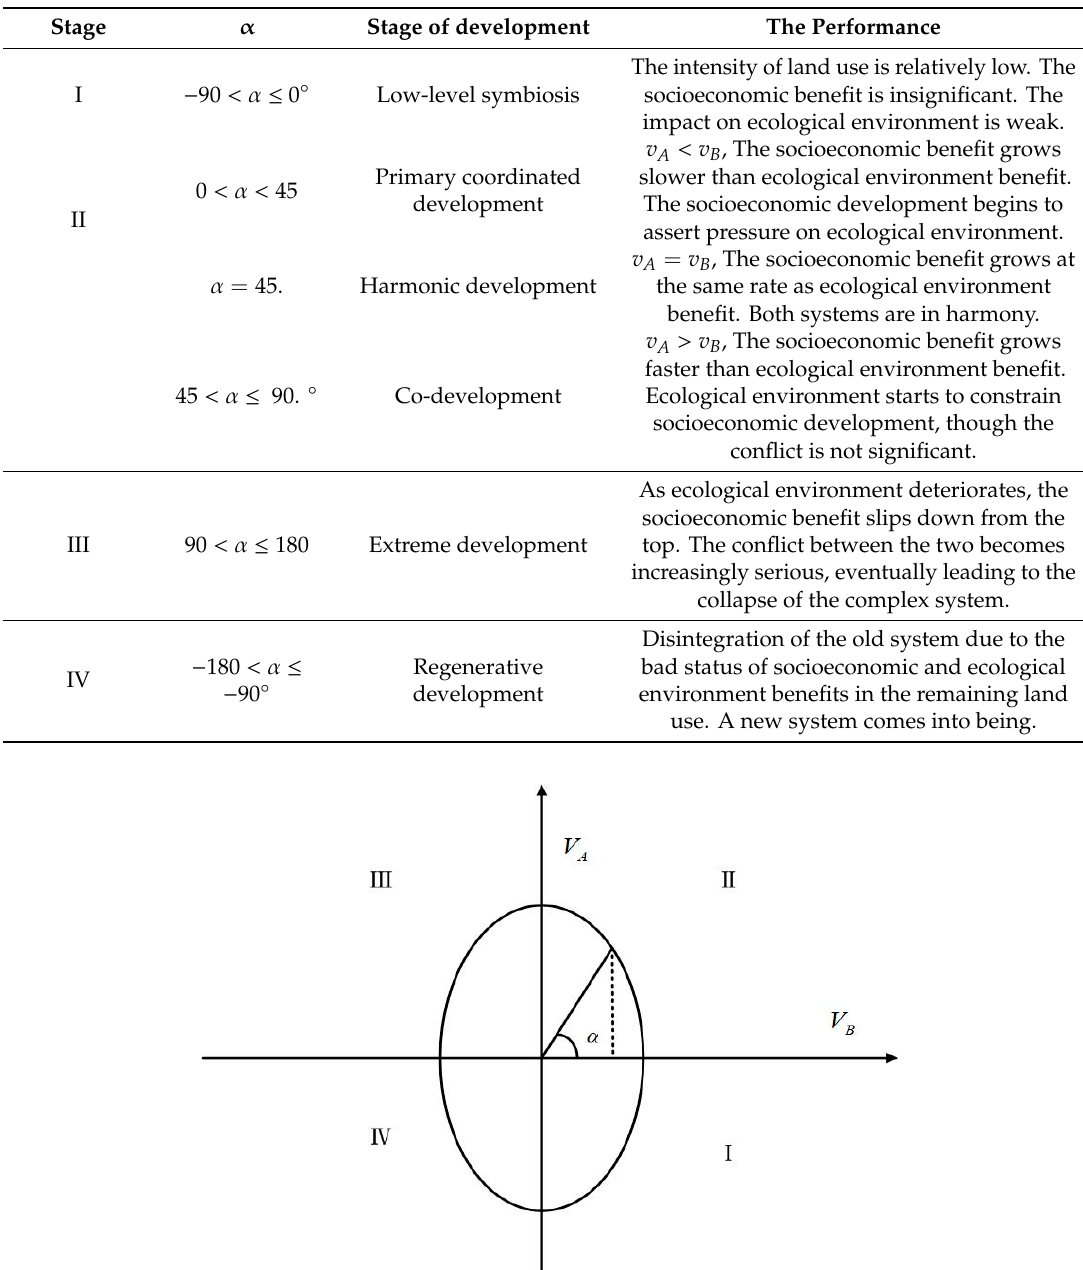
Table 3. The coupling degree of the land use benefits system.